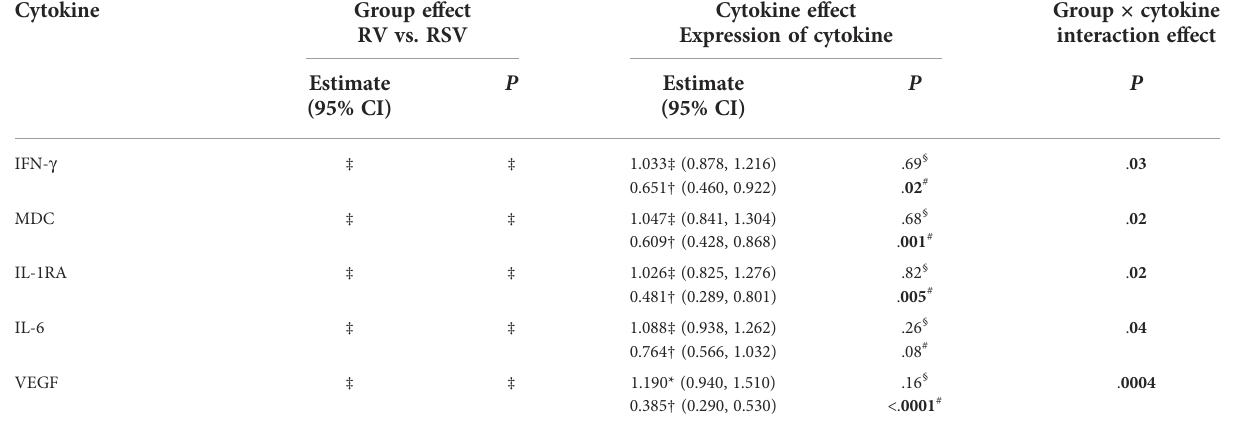
TABLE 3 Association between cytokine expression and severity of acute illness (duration of hospitalization). Cytokine